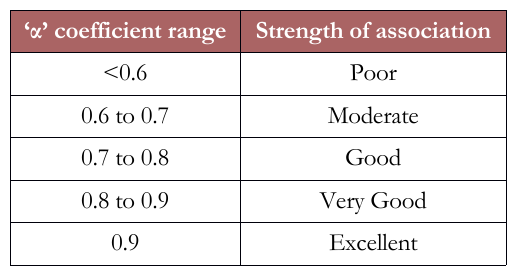
Table 3. Cronbach alpha coefficient (Hair, 2006)